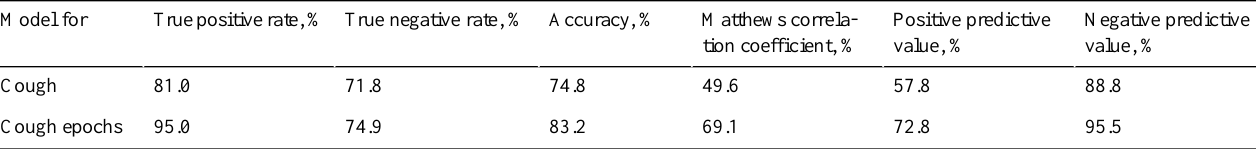
Table 2. Gaussian mixture model results of sex recognition for coughs and cough